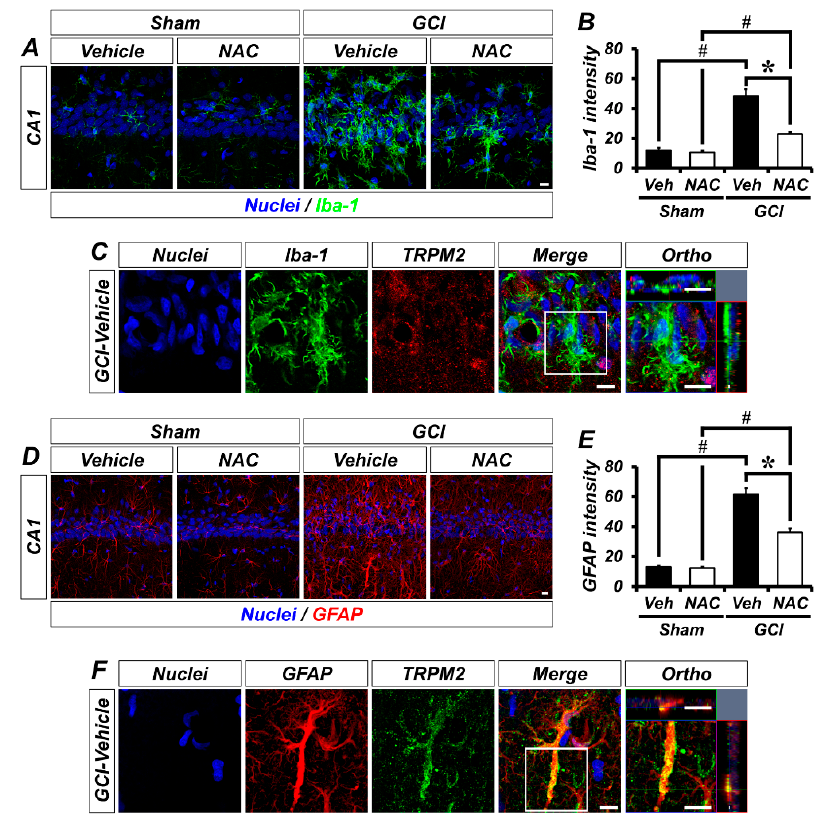
Figure 5. GCI-induced glial cell activation was attenuated by NAC treatment. ( A ) Microglial activation was estimated by Iba-1 immuno-staining. Sham groups (vehicle and NAC) had no di ff erence in Iba-1-positive signal (green color). GCI triggers excessive microglial activation in the hippocampal pyramidal layer, and this was attenuated by NAC administration for 3 days after onset of GCI. Scale bar = 10 µ m. ( B ) Bar graph representing intensity of Iba-1-positive signals from hippocampal pyramidal layer administered with vehicle and NAC for 3 days after sham and GCI surgery. Data are mean ± SEM, n = 5–7 each group, * p < 0.05 versus vehicle-treated group; # p < 0.05 versus sham-operated group (Kruskal–Wallis test followed by Bonferroni post-hoc test: chi square = 20.248, df = 3, p < 0.001). ( C ) Distribution of TRPM2 in microglial cells (merged image). ( D ) Astrocyte activation was evaluated by GFAP immuno-staining. Sham groups had no di ff erence in GFAP-positive signal (red color). Astrocyte activation was stimulated by GCI, and reduced by NAC administration. Scale bar = 10 µ m. ( E ) Bar graph displaying intensity of GFAP-positive signals from the hippocampal pyramidal layer in vehicle and NAC-treated groups after sham and GCI surgery. Data are mean ± SEM, n = 5–6 each group, * p < 0.05 versus vehicle-treated group; # p < 0.05 versus sham-operated group (Kruskal–Wallis test followed by Bonferroni post-hoc test: chi square = 18.747, df = 3, p < 0.001). ( F ) Distribution of TRPM2 in astrocyte following GCI (merged image).